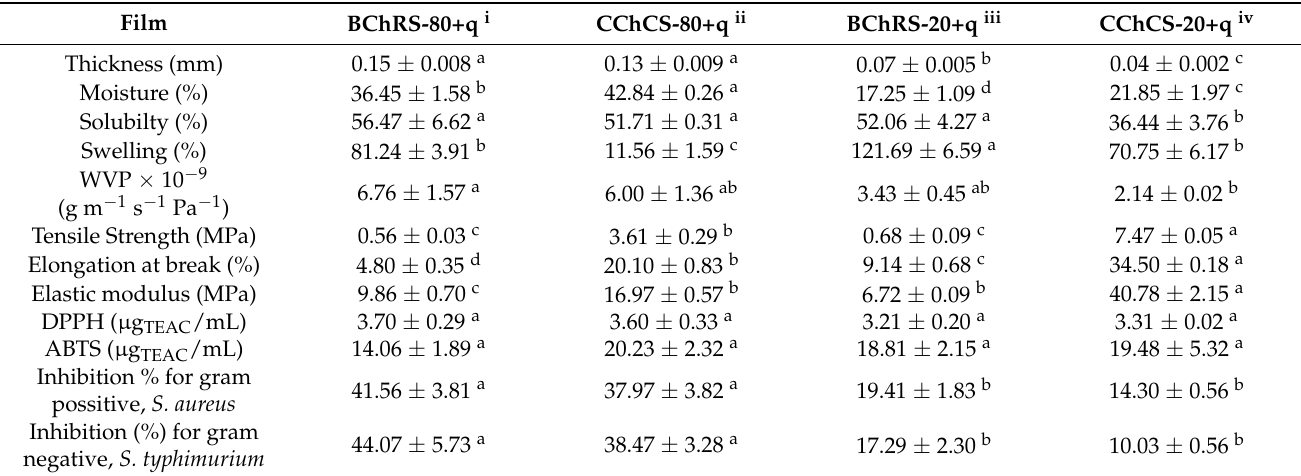
Table 2. Physicochemical and mechanical properties, antioxidant, and antimicrobial activities